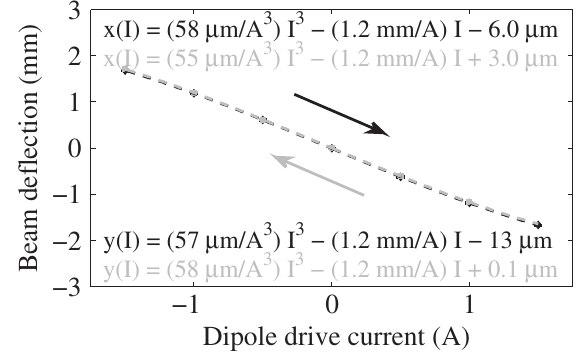
FIG. 10. Measured beam steering right (top black), left (top gray), down (bottom black) and up (bottom gray) across the MCP. Black steering data was taken while increasing the current and grey data was taken while reducing the current. Hysteresis and nonlinearity is less than the measurement error, resulting in the y(I) line overlaying most of the other